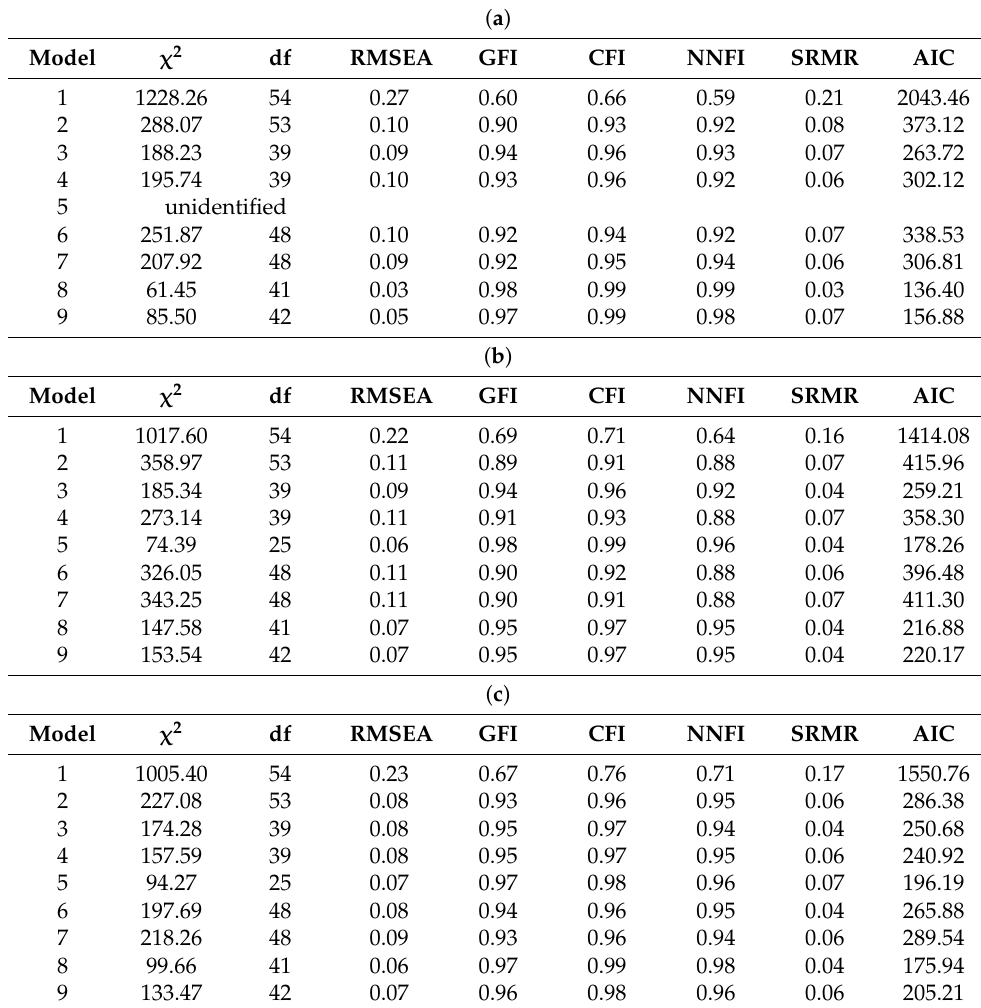
Table 2. ( a ) Fit Indices of Models (STOSA); ( b ) Fit Indices of Models (STOSASS-a); and ( c ) Fit Indices of Models